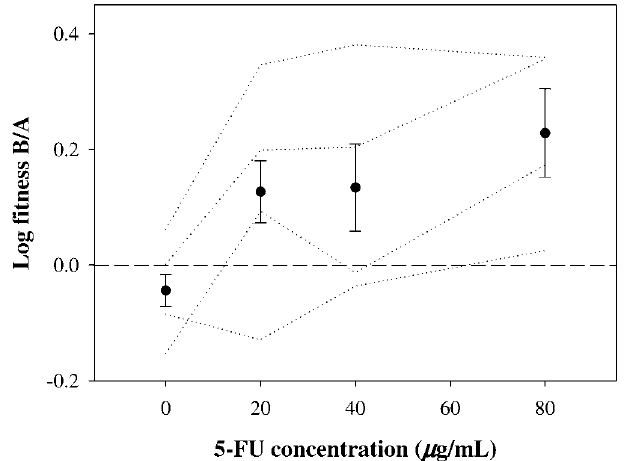
Figure 4. Competition Experiments between Pairs of Clones at Varying 5-FU Doses The log-fitness of clones from population B relative to those from A, log( W B / W A ), is represented. Dotted lines represent each of the four clone pairs, circles the grand-log-fitness mean, and bars indicate standard errors of grand means. An analysis of the variance revealed a significant effect of both the clone pair ( F 3,43 ¼ 9.871, p , 0.001) and the 5-FU dose ( F 1,43 ¼ 9.871, p ¼ 0.001) on the observed mean log-fitness.